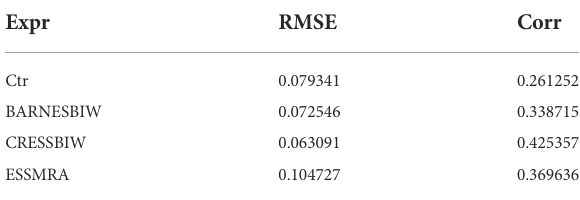
TABLE 2 Average calculation of hourly RMSEs and Corrs between station observations and each product of Ctr, CRESSBIW, and